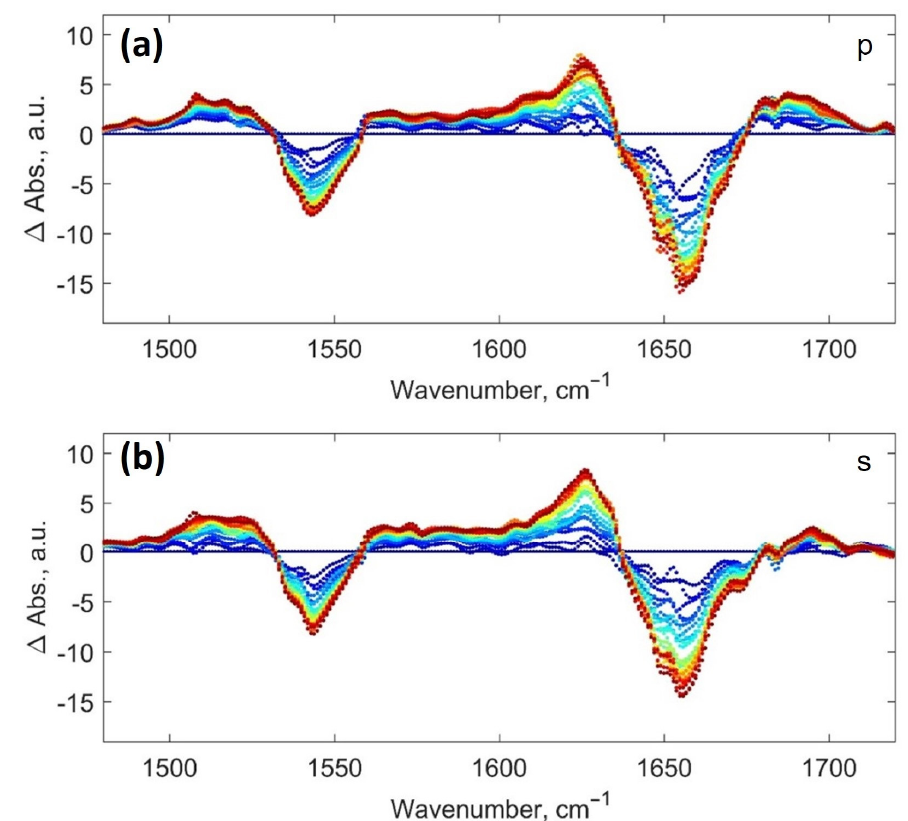
Figure 4. Difference between spectra recorded during Lys adsorption on the blank crystal compared to the first spectrum of Lys on the blank crystal for p ( a ) and s ( b ) polarizations. The change in color of the data presented from cold to warm reflects the direction of the time span. Mean values in each case of five spectra are taken to decrease the noise. The time interval between the presented spectra is around 13 min.